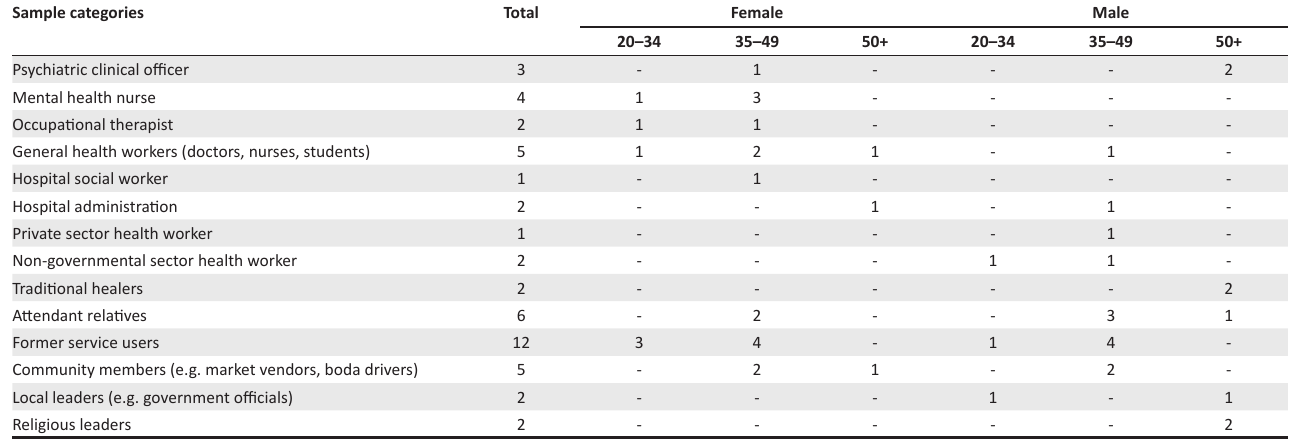
TABLE 1: Interviewees by population, age and gender. Sample